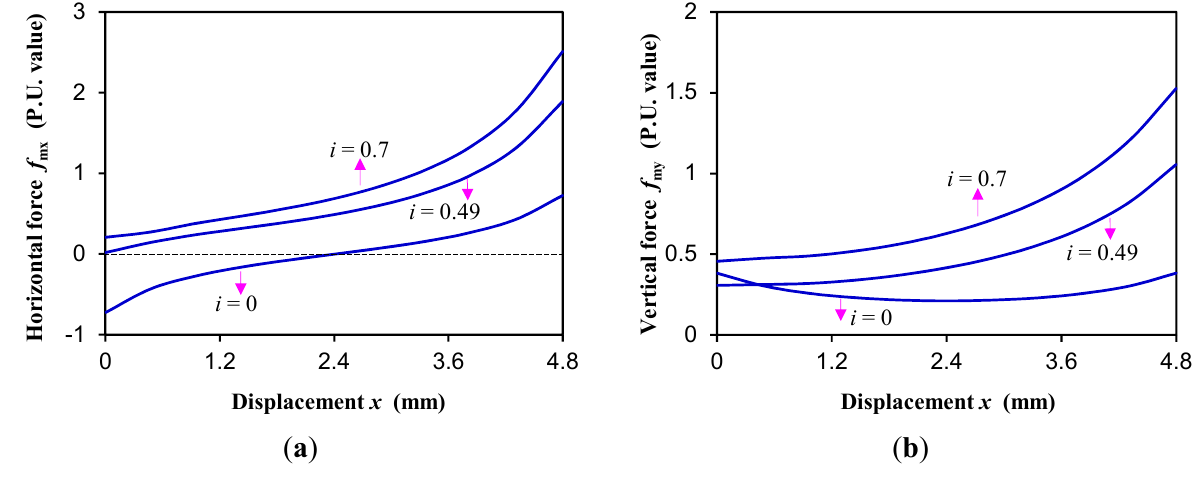
Figure 7. Electromagnetic forces. ( a ) Horizontal; ( b )